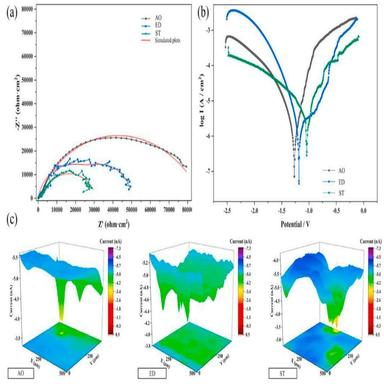
Electrochemical corrosion resistances of three prepared samples measured by (a, b) electrochemical work station and (c) SECM.